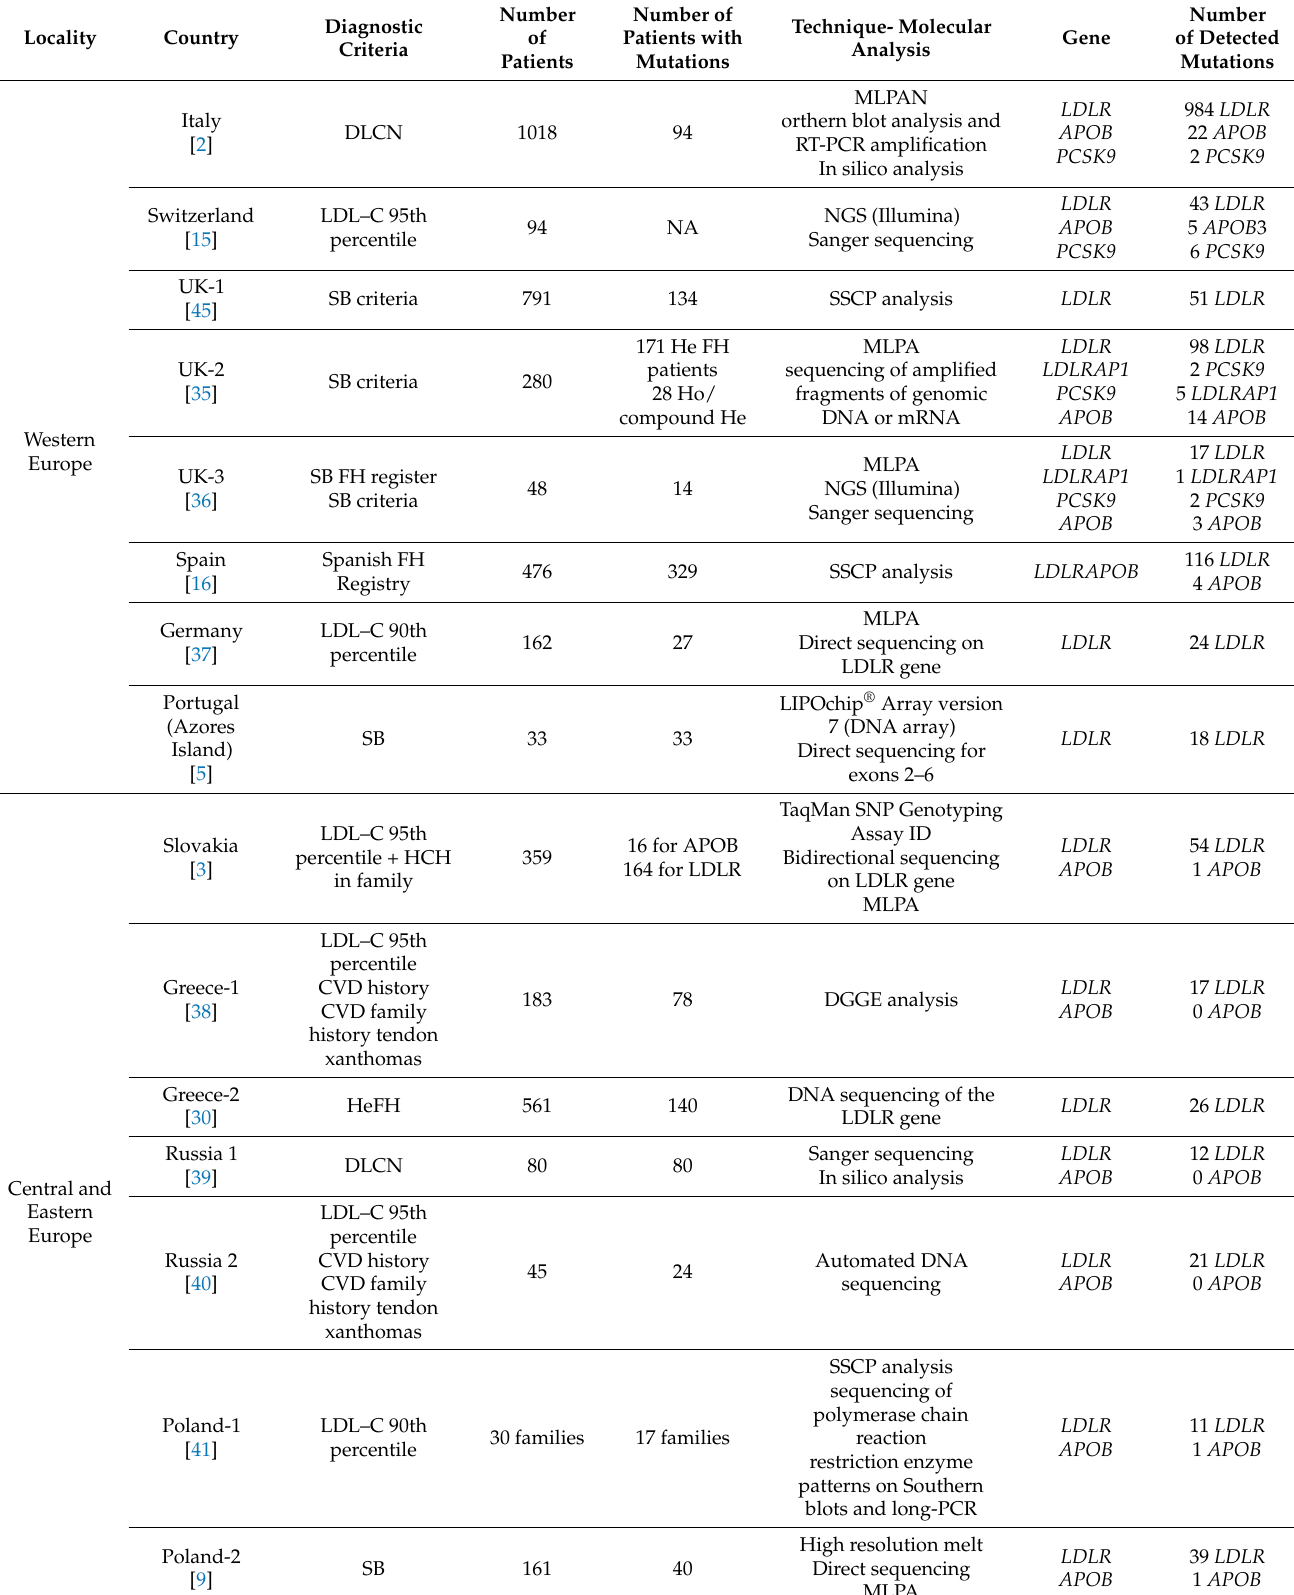
Table 5. Characteristics of different studies for genotypes of the FH